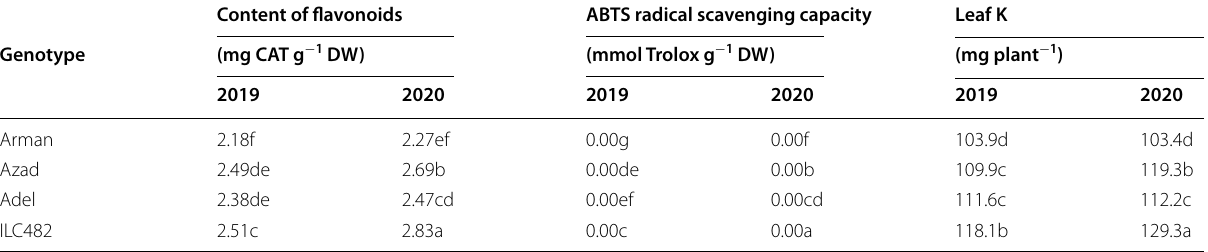
Adel Each parameter with the same letter is not significantly different according to LSD test at the 5% level of probability